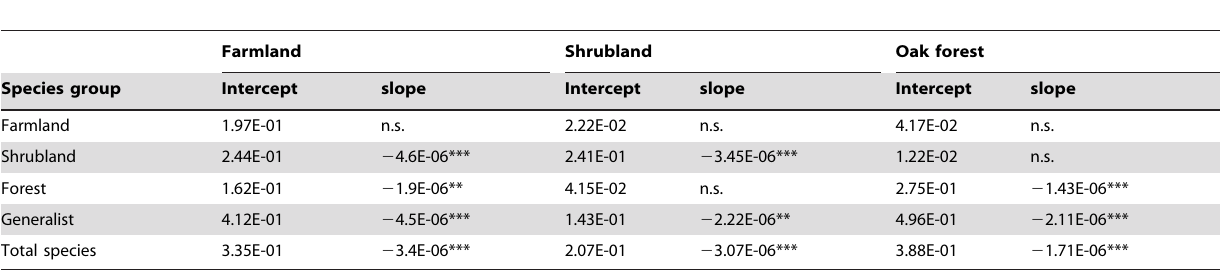
Table 2. Regional species similarity decay of each species group and of the total species in the three land-uses.